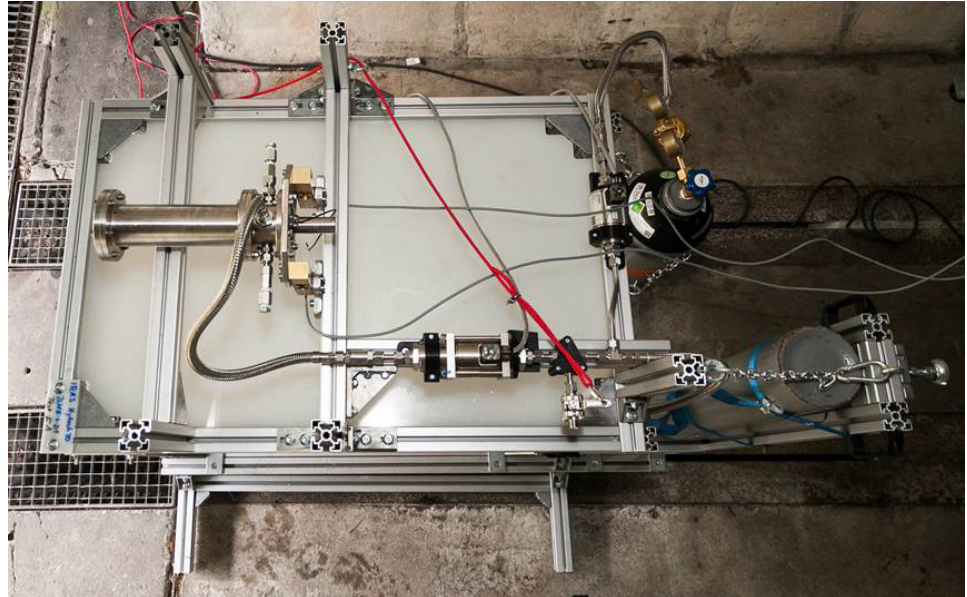
Figure 10. Overview of the engine test